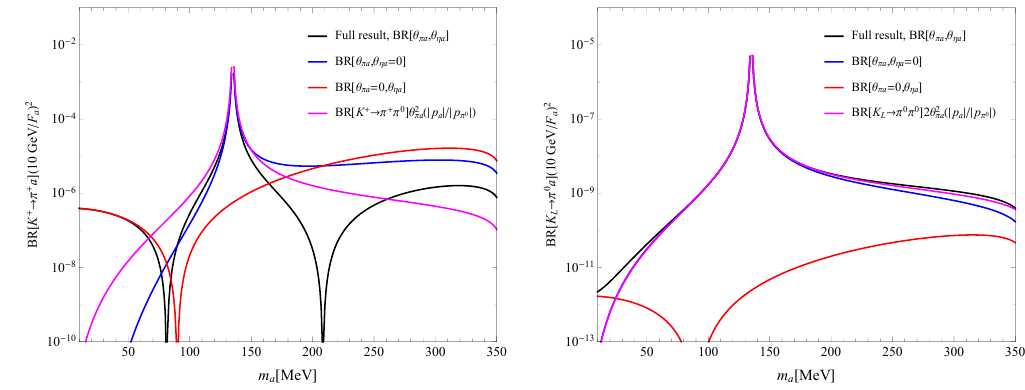
Figure 14 . Left: comparison of our full calculation for BR( K + ! (cid:25) + a ) (in black) to other estimates. The naive scaling of the SM BR( K + ! (cid:25) + (cid:25) 0 ) is shown in pink (see (C.15)). The result that keeps into account only the ALP-pion mixing is shown in blue, the one with only the ALP-eta mixing is shown in red. The analogous comparison of the BR( K L ! (cid:25) 0 a ) calculations is reported on the right